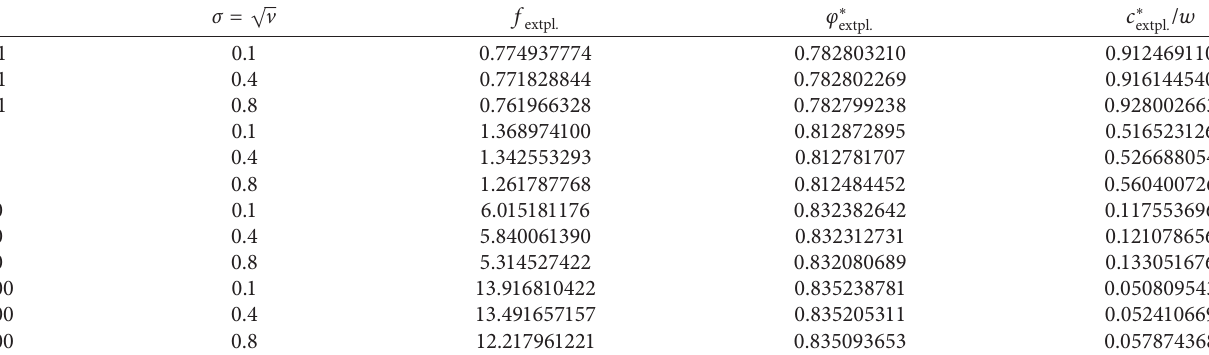
Table 12: Numerical solutions for f, φ ∗ , and c ∗ / w after performing Richardson’s extrapolation. Here, α � 0 . 5 and Δ τ � Δ v � 0 . 001. Other parameter values are the same as those in Table 1.